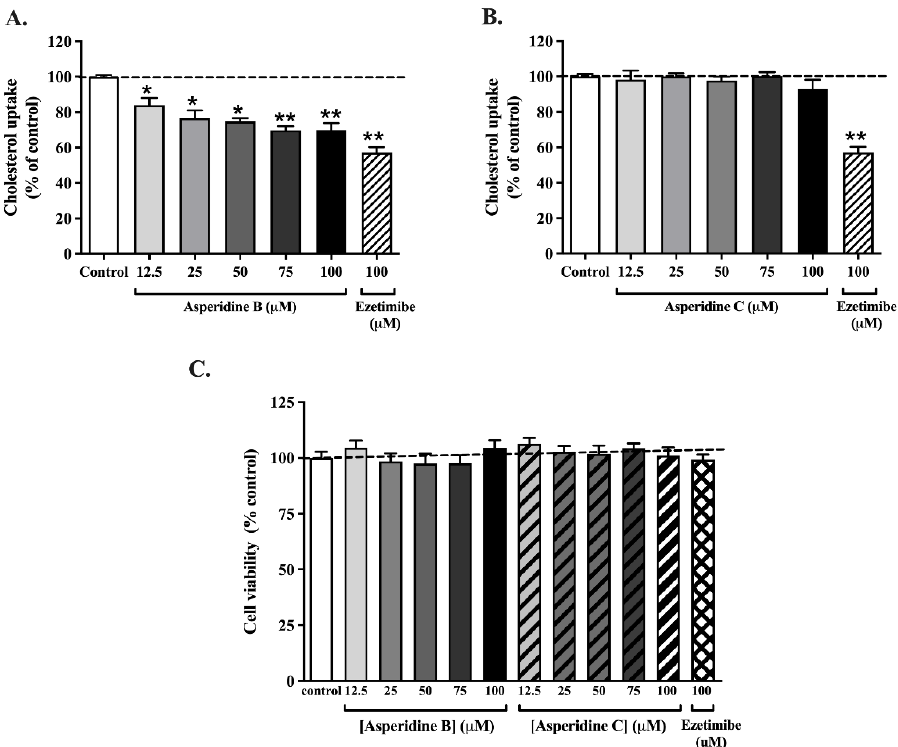
Figure 3. Effect of asperidine B (preussin) and asperidine C on [ 3 H]-cholesterol mixed micelle transport in intestinal Caco-2 cells. ( A ) Asperidine B and ( B ) asperidine C at 12.5–100 µ M or 100 µ M ezetimibe were co-incubated with 1 µ Ci/mL [ 3 H]-cholesterol mixed micelles for 30 min at 37 ◦ C ( n = 5). ( C ) Viability of CacO-2 cells after exposure to asperidine B, asperidine C, or ezetimibe at the same concentrations as shown in ( A , B ). Caco-2 cells were pre-incubated with tested compounds for 3 h and incubated with an MTT reagent. Absorbance was measured at a wavelength of 570 nm and percentage cell viability was compared with control cells. Data are represented as mean ± SEM ( n = 5); * p < 0.05, ** p < 0.01 vs. control.